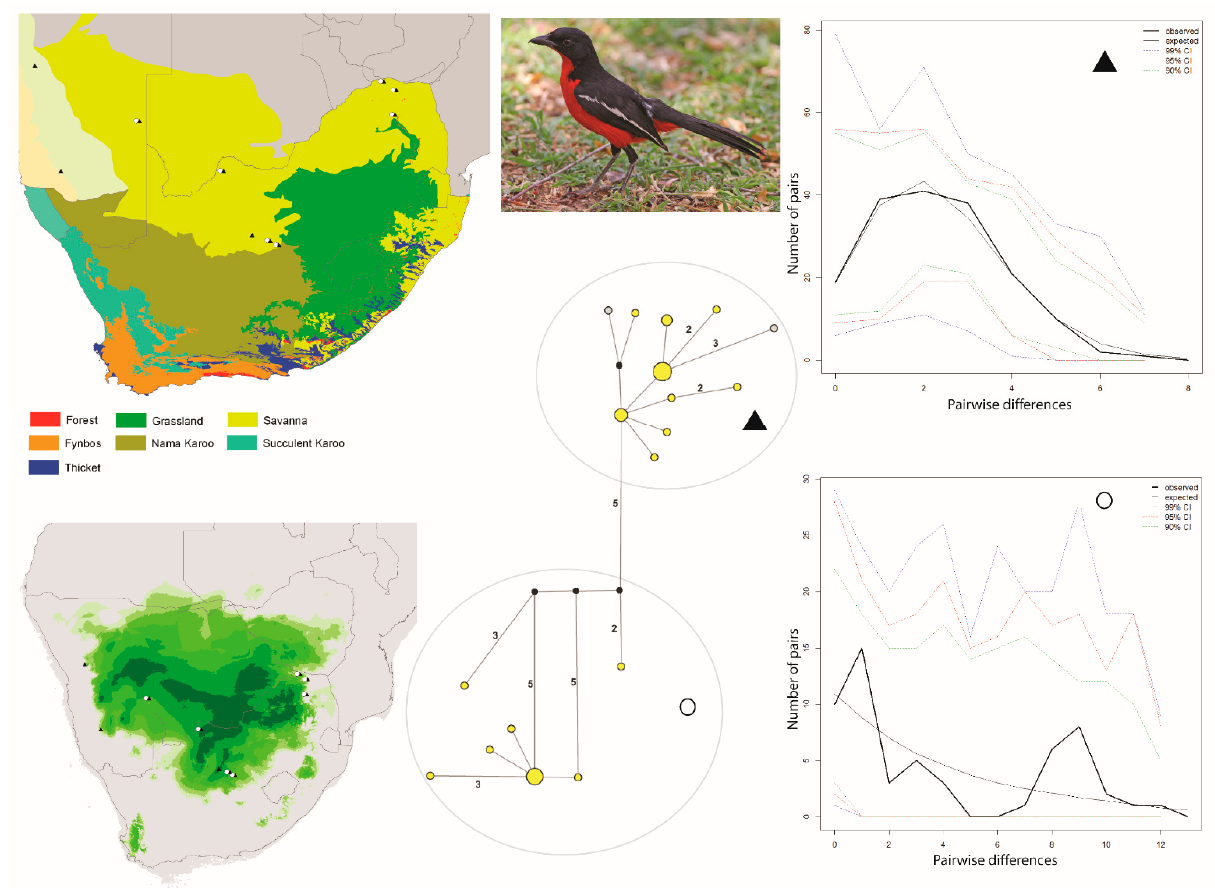
Figure 2. Maps and results from analyses of Laniarius atrococcineus . The haplotype analysis ( middle bottom ) recovered two clusters, represented by O and ▲ , within southern Africa that are separated by five mutational steps; circle sizes in the networks correspond to the number of individuals with that haplotype (larger circles reflect more individuals with that haplotype), and black circles represent unsampled haplotypes. Other colors represent the biome(s) in which a haplotype was collected ( top left ); however, circle size has no relationship to the number of individuals from a given biome (if a haplotype is found in more than one biome)—in other words, just one individual from a specific biome would contribute that biome color to the circle. The geographic distribution of individuals in each haplotype cluster are depicted with respect to biome type ( top left ) and to the estimated species stability map ( bottom left ) is summed across all time slices, with darker shades of green indicating areas of higher stability. Mismatch distributions for each haplotype cluster depict demographic trends within each haplotype cluster ( right , top , and bottom ), where solid lines depict expected (black) and observed (black bold) pairwise differences, and dotted lines depict confidence intervals at 99% (blue), 95% (red), and 90% (green). Photo by Ron Knight (https://search.creativecommons.org/photos/cb5f39e3-f4a7-4467-b2b0-a6064bd53bef, accessed 10 January 2021).